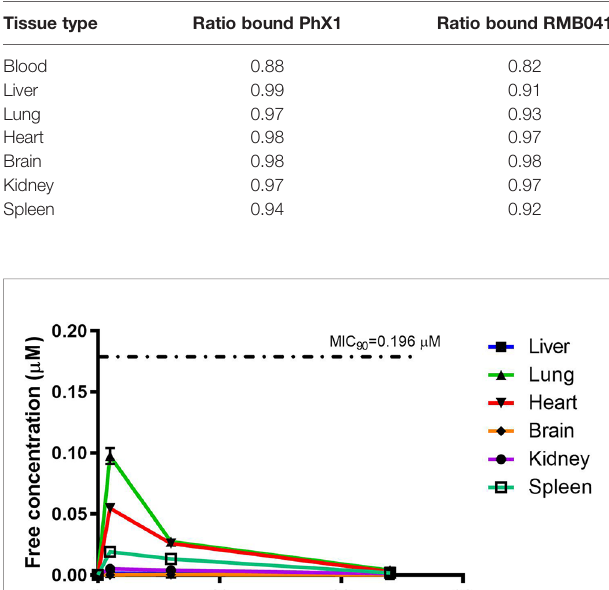
TABLE 3 | PhX1 and RMB 041 bound ratio in speci fi c tissue types.